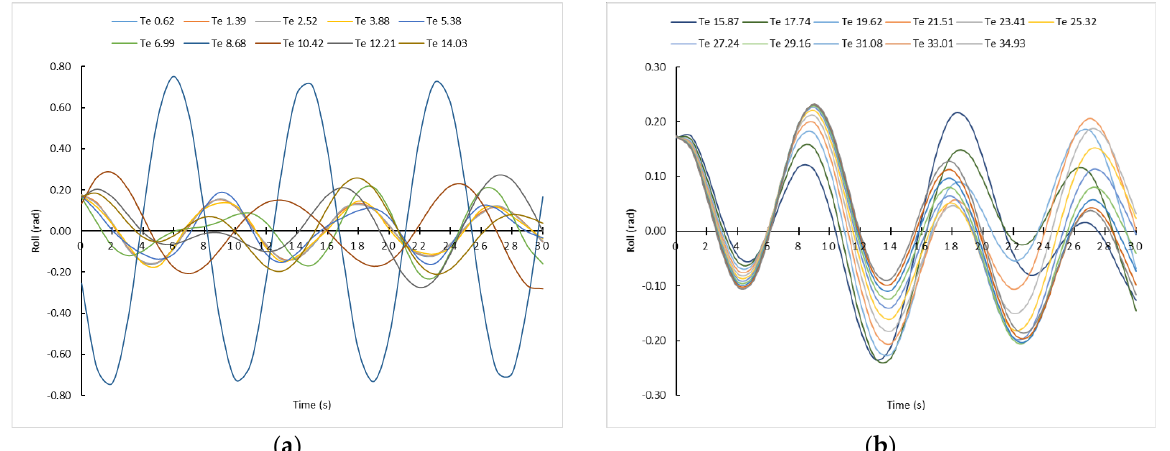
Figure 3. Rolling motion sailing at 8.0 knots and induced by waves with resistance with an α angle of 45°. ( a ) Te from 0.62 s to 14.3 s. ( b ) Tw from 15.87 s to 34.93 s.